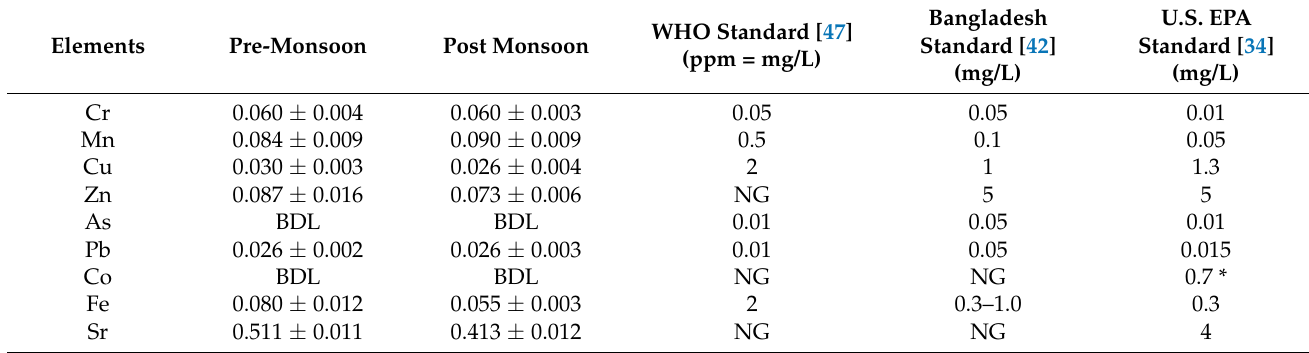
Table 2. Average concentration (mg/L) of metals in the water sample, n =